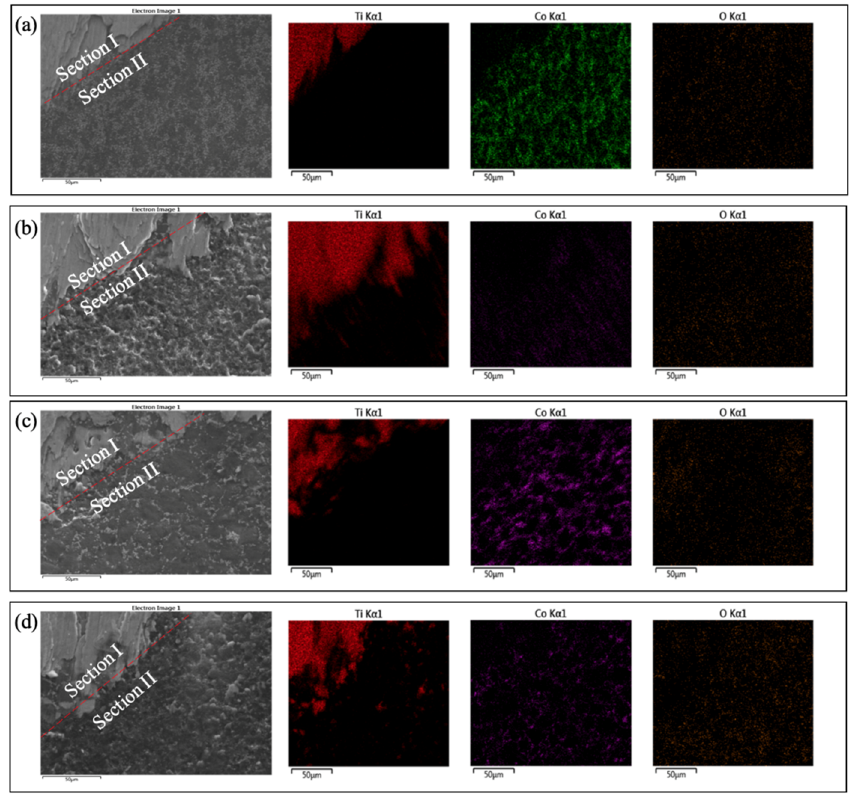
Figure 13. Distribution of titanium, cobalt and oxygen on the worn areas of the four PCD inserts: ( a ) 002A, ( b ) 002E, ( c ) 302A, and ( d )